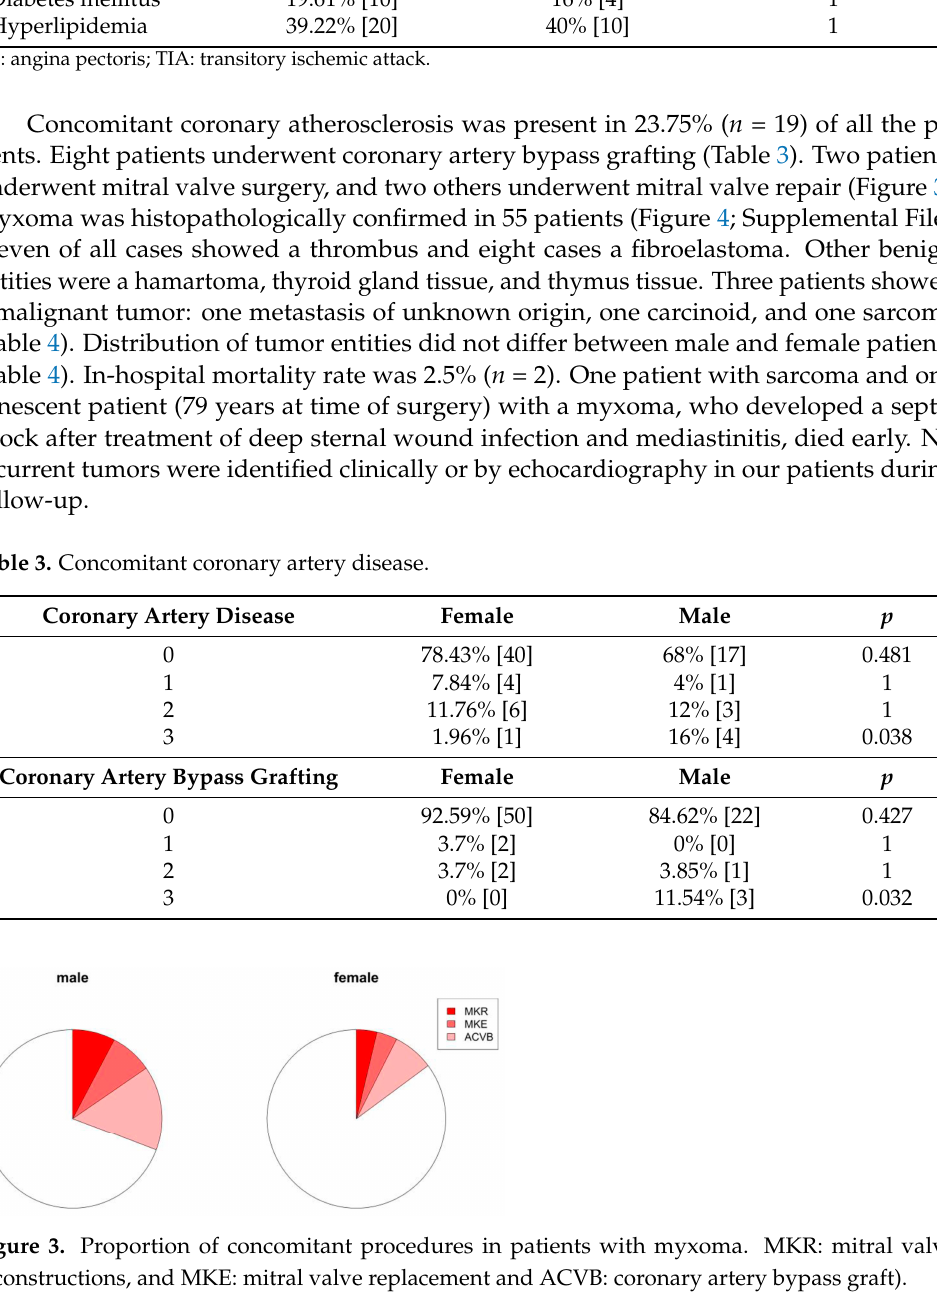
( b ) Figure 4. ( a , b ) Exemplary resected left atrial myxoma of approximately 70 mm length and 30 mm diameter. Polypoid tumor with oval shape and smooth, slightly lobulated surface. Note the resected part of the interatrial septum with septal myocardium to which the myxoma is attached (*). Table 4. Histopathology ( n = 80) Histopathology